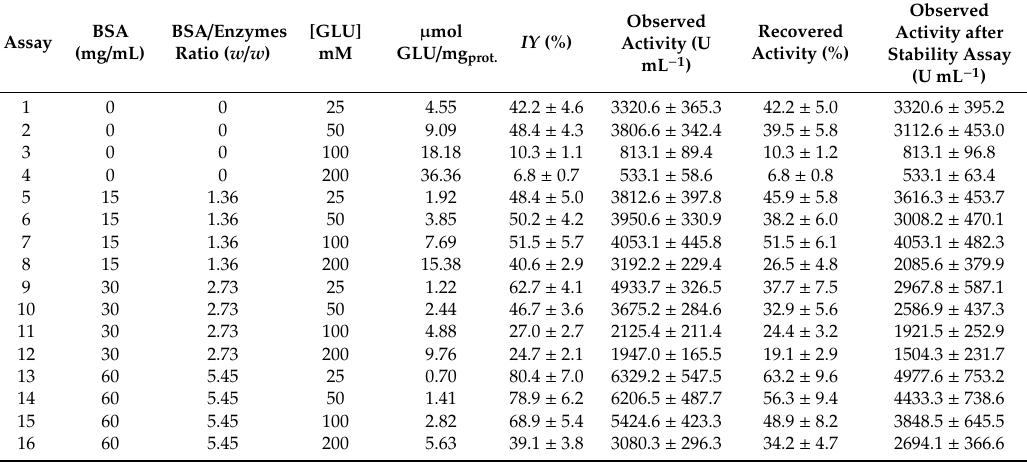
Table A2. Immobilization yield ( IY ) and recovered activity after the stability assay of catalase (CAT) immobilized by the combi-CLEA technique: influence of the glutaraldehyde concentration (GLU) and BSA / enzymes ratios ( w / w